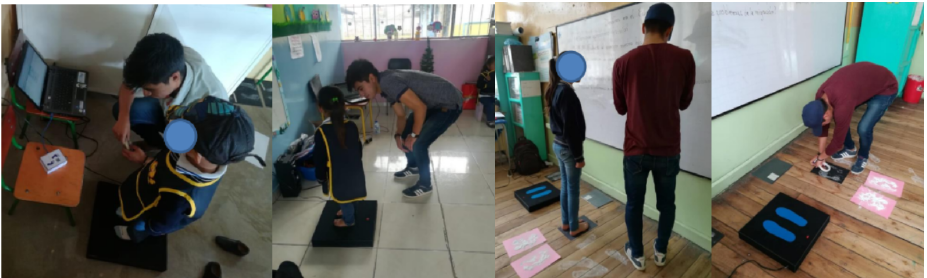
Figure 9. Program volunteers during the acquisition of the real data. The embedded FBS was operated under a controlled